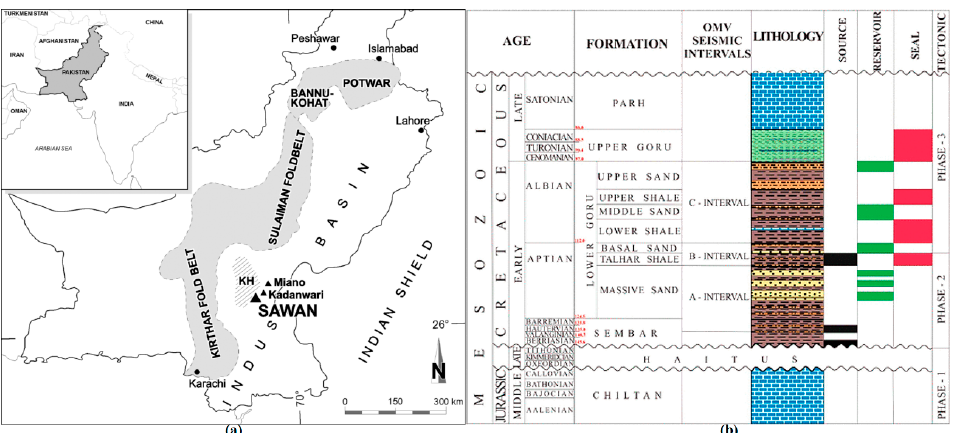
Figure 1. ( a ) Structural map of Pakistan with the location of the Sawan Gas Field, ( b ) Generalized stratigraphic column of the Lower Indus Basin with highlighted C-sand interval.